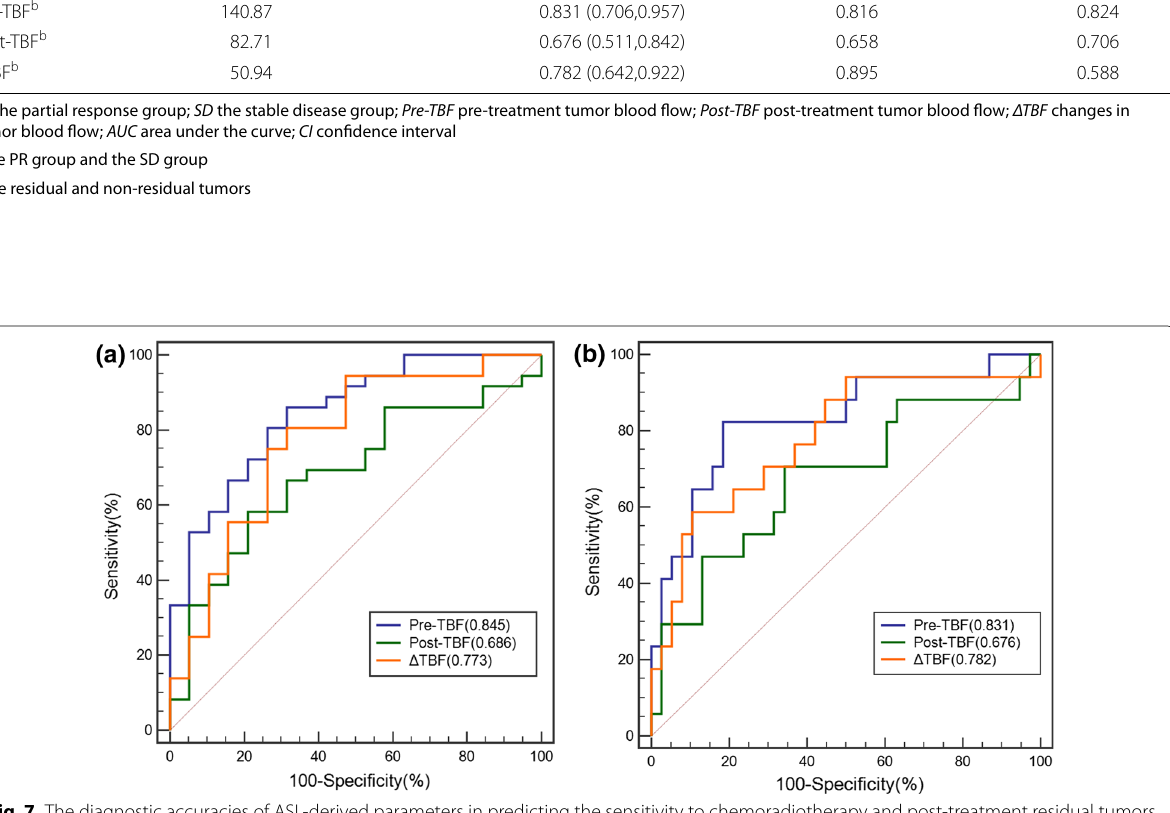
Fig. 7 The diagnostic accuracies of ASL-derived parameters in predicting the sensitivity to chemoradiotherapy and post-treatment residual tumors. The receiver operating characteristic (ROC) curve ( a ) represents the diagnostic efficacies of Pre-TBF (blue), Post-TBF (green), and ΔTBF (orange) in predicting sensitivity to chemoradiotherapy; ROC curve ( b ) represents the diagnostic efficacies of Pre-TBF (blue), Post-TBF (green), and ΔTBF (orange) in predicting post-treatment residual tumors. Pre-TBF: pre-treatment tumor blood flow, Post-TBF: post-treatment tumor blood flow, ΔTBF: changes in tumor blood